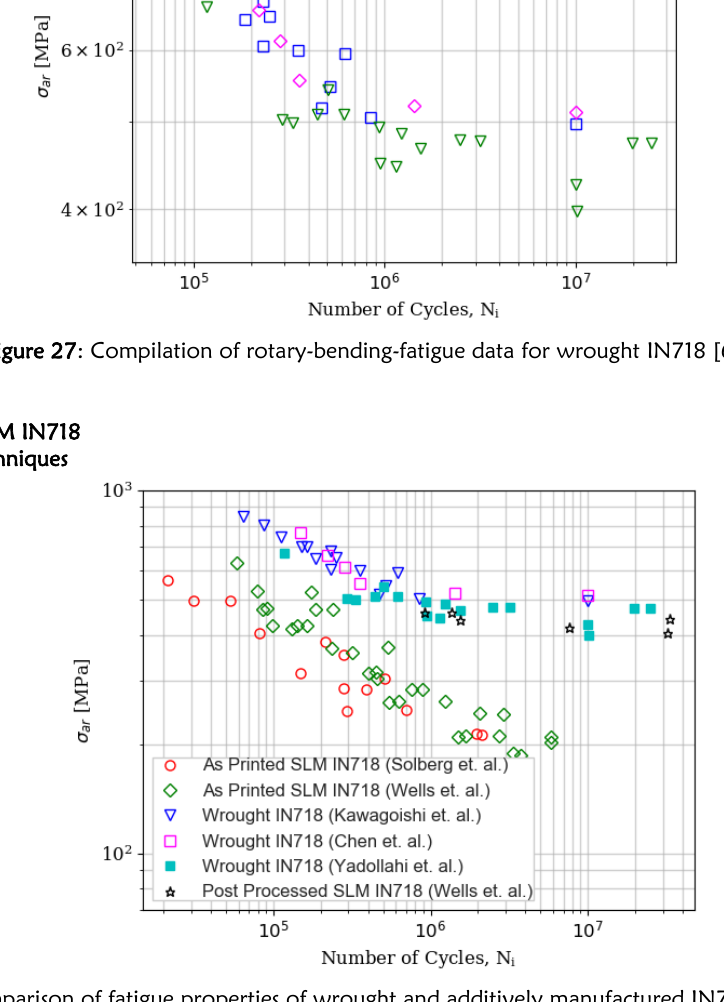
Figure 28: Comparison of fatigue properties of wrought and additively manufactured IN718